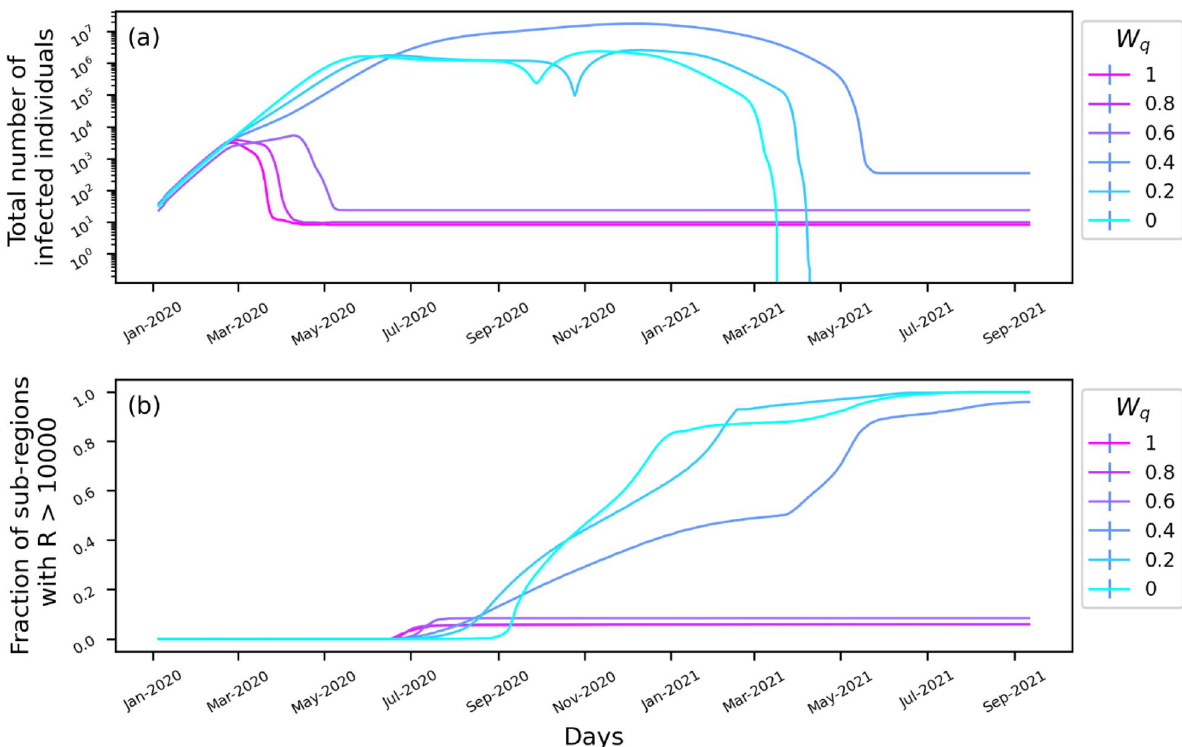
Figure 4. Effect of lockdown and quarantine on the spread of COVID-19 infection. The simulated change in the ( a ) total number of infected individuals (identified and unidentified) and ( b ) the number of sub-regions/ compartments with more than 1000 recovered cases as a function of the parameter, Wq.